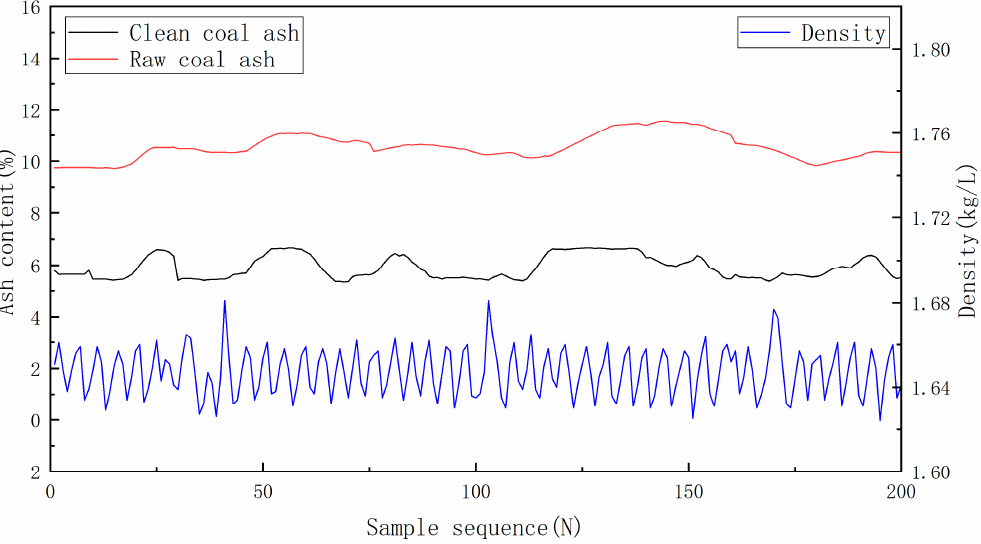
Table 2. RMSE of different hidden layers and nodes. Nodes Hidden Layers